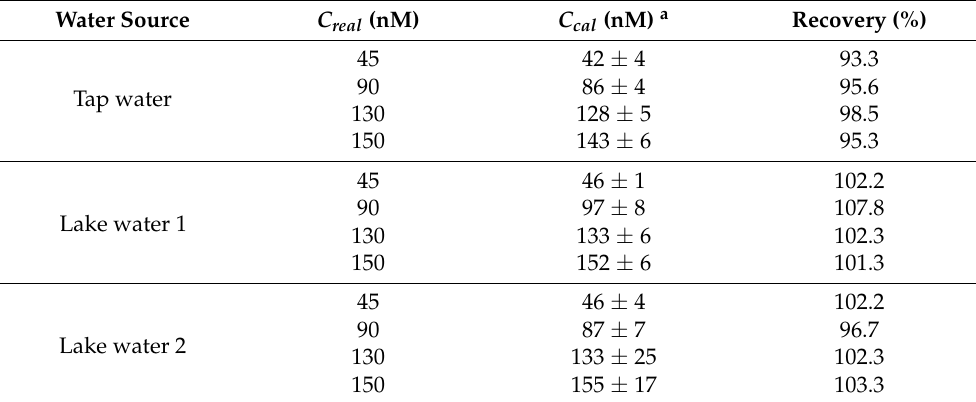
Table 1. Ag + detection in tap and lake waters using the M-DNA sensor.